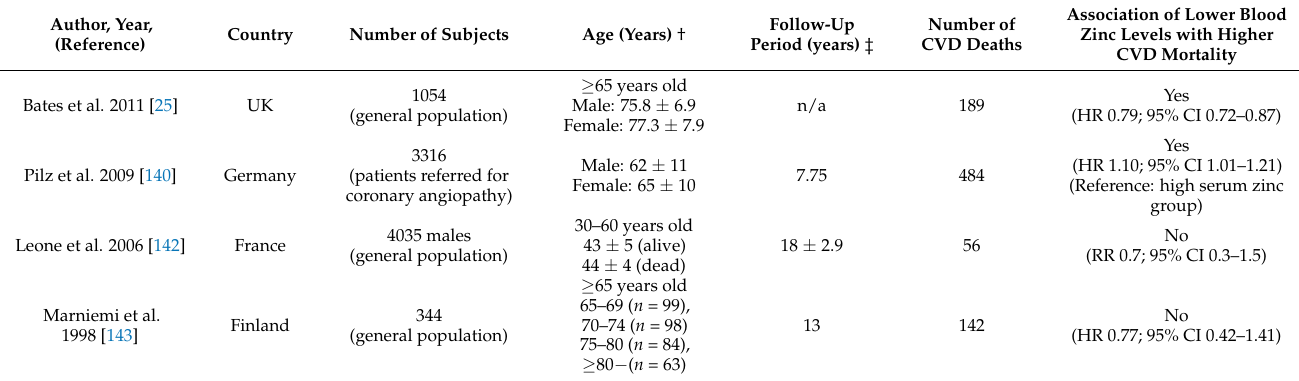
Table 2. Summary of cohort studies regarding blood zinc levels and CVD